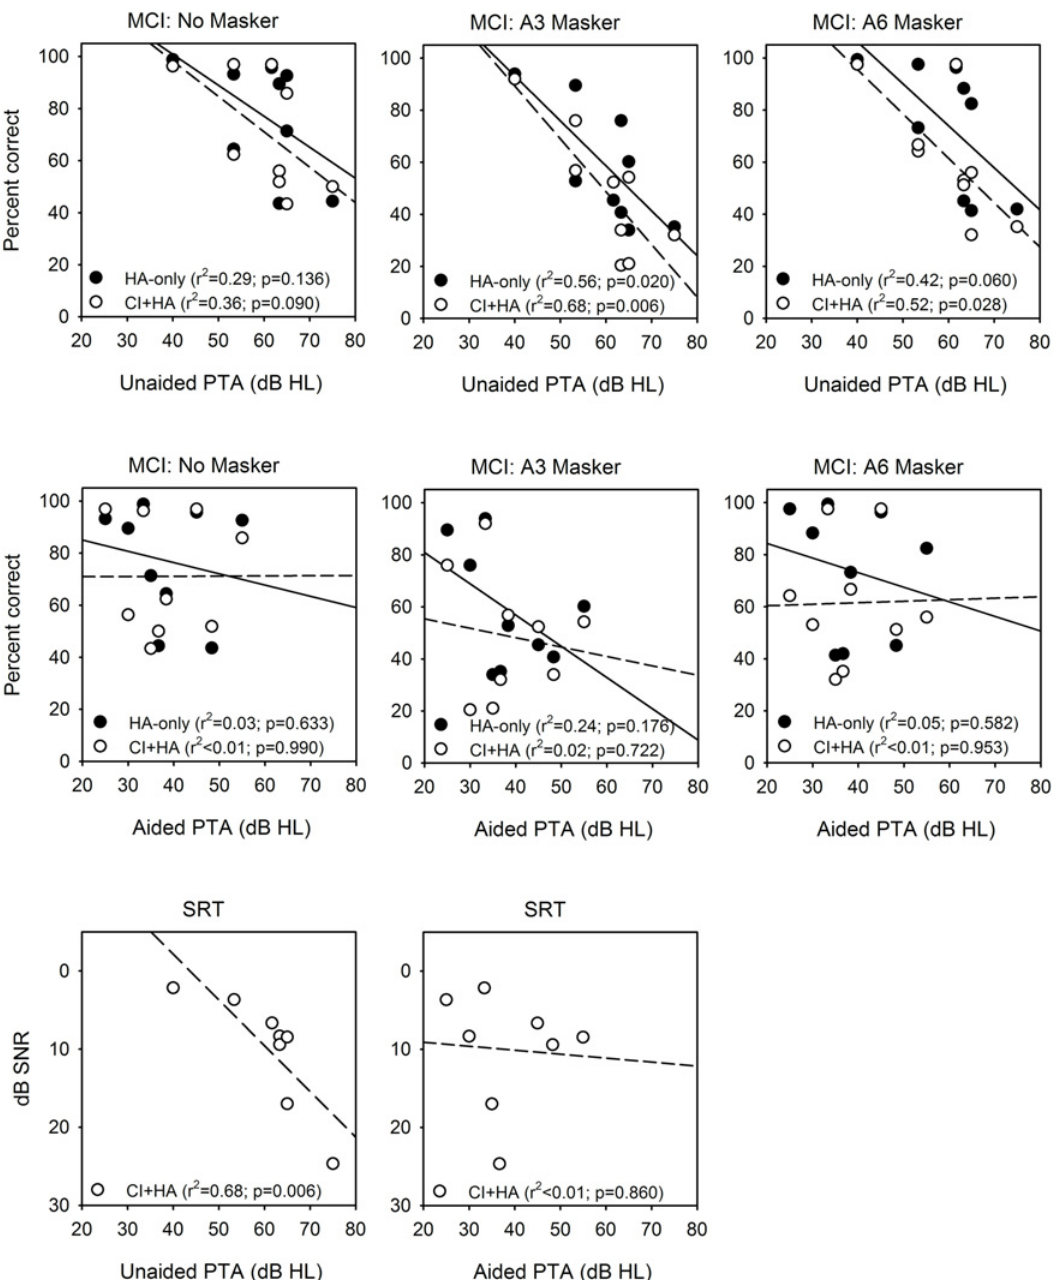
Fig 7. Scatter plots of music and speech performance versus unaided and aided thresholds in the non-implanted ear. The top row shows MCI performance for the No Masker (left), A3 Masker (middle), and A6 Masker conditions (right), as a function of unaided PTAs at 125 Hz, 250 Hz, and 500 Hz. The solid circles show data for the HA-only condition; the solid line shows the linear regression (r 2 and p-values are shown in the legend in each panel). The open circles show data for the CI+HA condition; the dashed line shows the linear regression. The middle row shows similar plots, but as a function of aided PTAs at 125 Hz, 250 Hz, and 500 Hz. The bottom row shows SRTs as a function of unaided PTAs (left) or aided PTAs (middle). Only CI+HA SRT data is